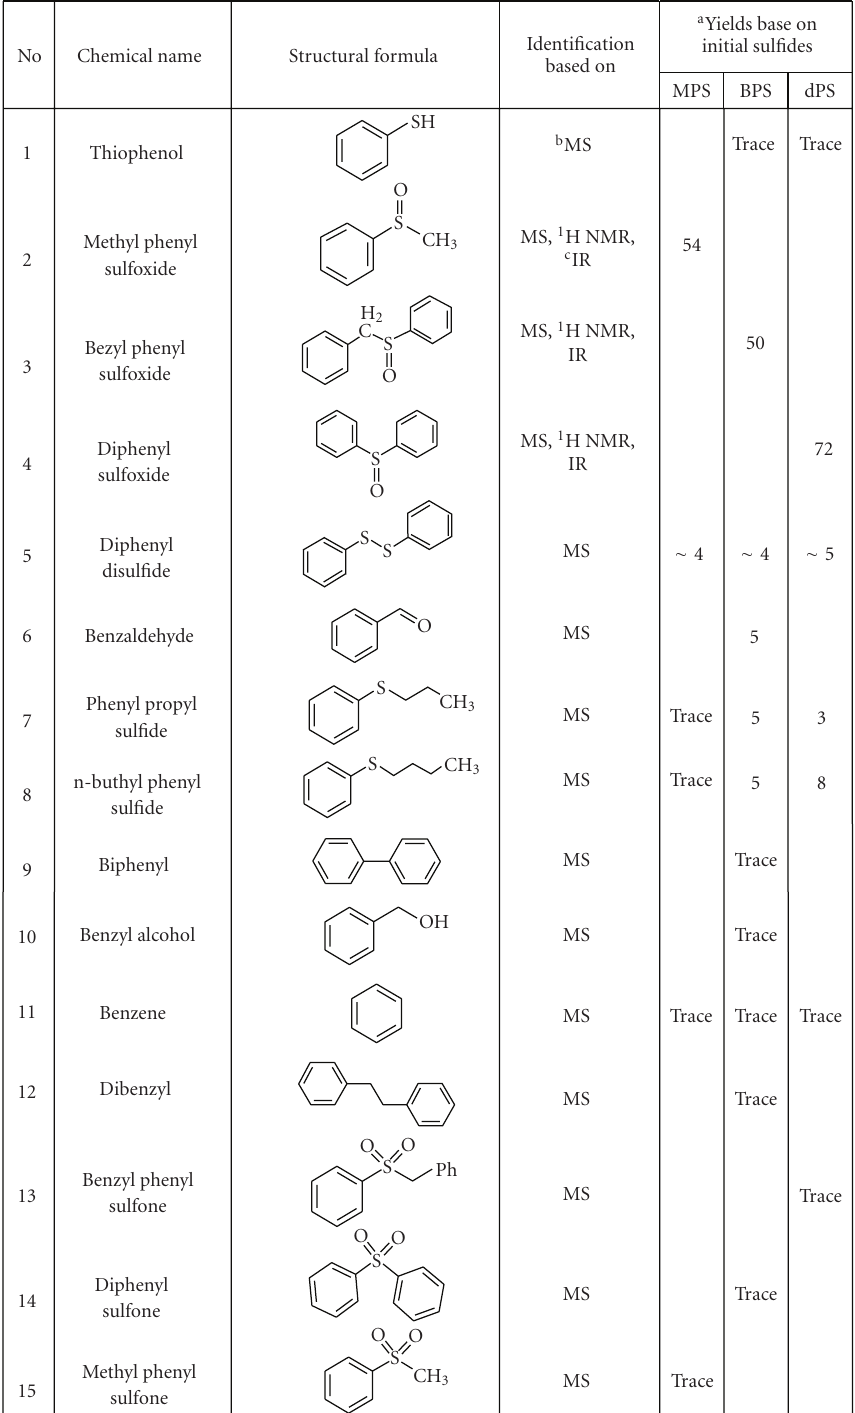
Table 1: List of the observed oxidation products and their percentages during photocatalytic oxidation of 20 mL aqueous-acetonitrilic (5/95) 10 (cid:0) 2 M) over TiO 2 using 400 W high pressure mercury lamp at 25–30 Æ C after 24h irradiation time; and solution of MPS, BPS or dPS (5 (cid:0) flux of O 2 (5mL min (cid:0) 1